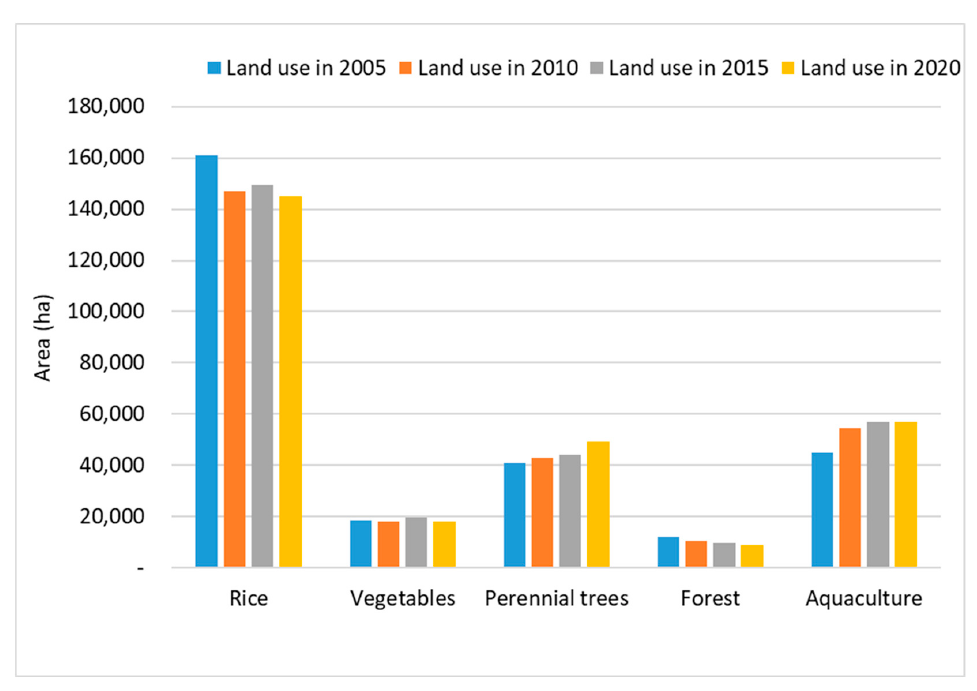
Figure 5. Land use in Soc Trang province in 2005–2020. (Source: Generated from statistical data [43–46]).